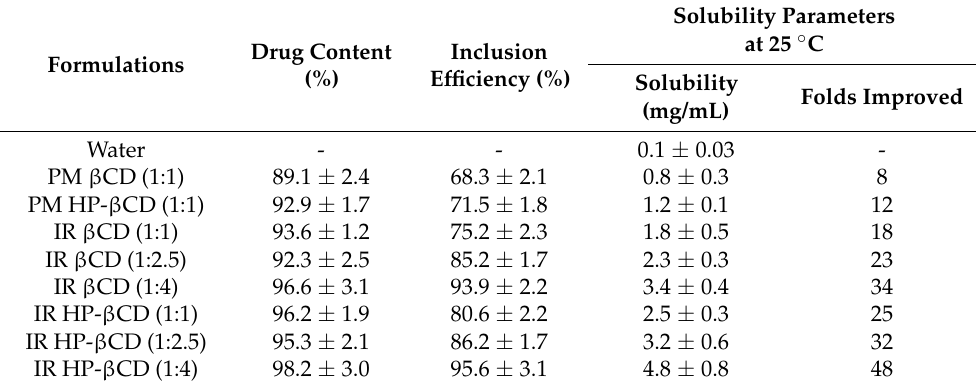
Table 1. Drug content and inclusion efficiency of irbesartan from PMs, IR- β CD, and IR-HP- β CD inclusion complexes (mean ± SD, n =